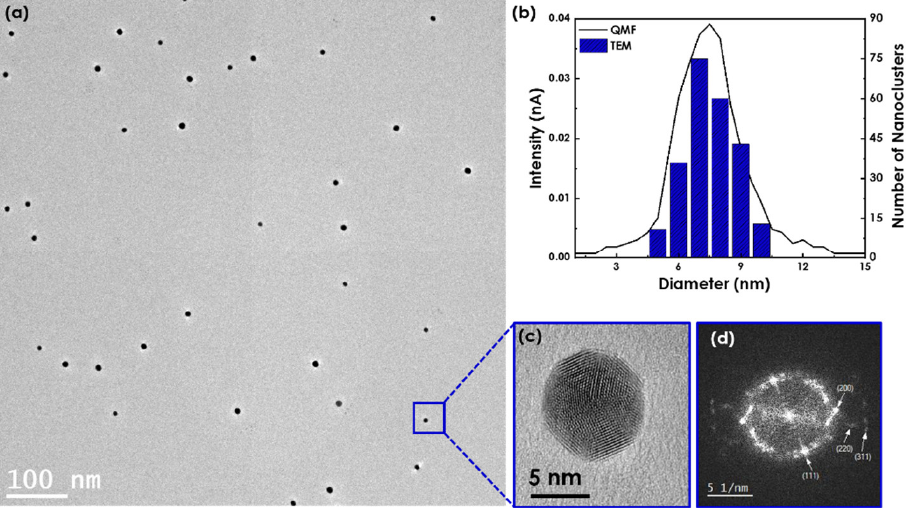
Figure 2. ( a ) Low-magnification, bright-field TEM image of the fabricated Au nanoclusters. ( b ) Size distributions of QCM and TEM. ( c ) High-magnification, bright-field TEM image of a single Au nanocluster and ( d ) its corresponding FFT.